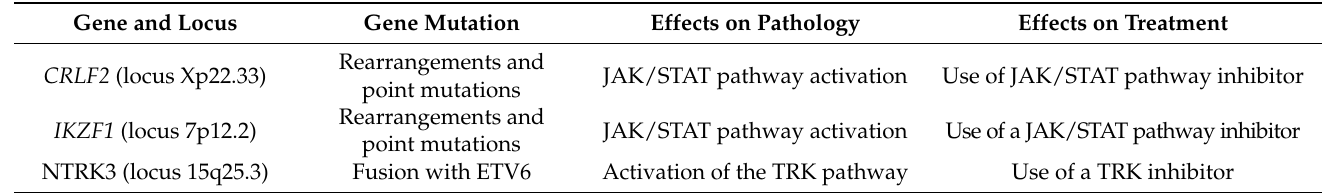
Table 8. Summary of genes responsible for activating metabolic pathways in ALL Ph-like; their mutations and treatment